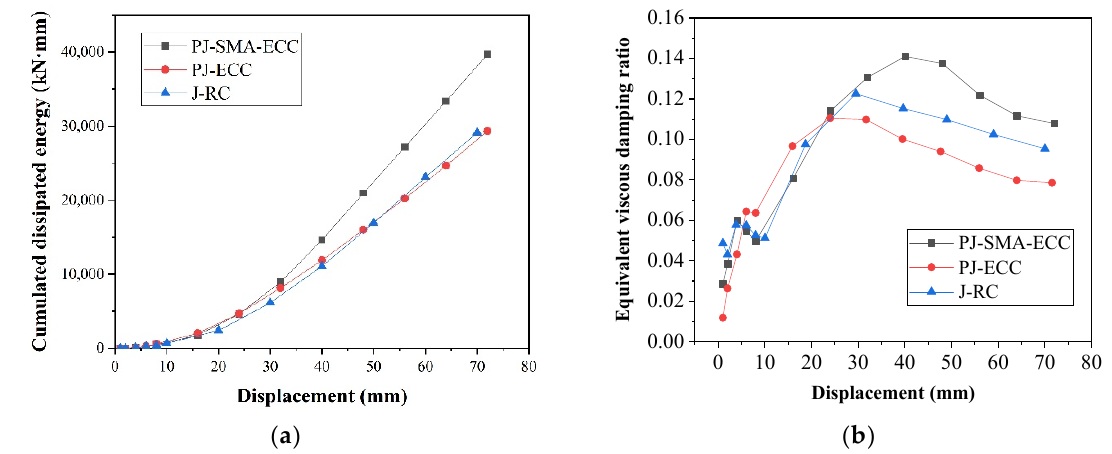
Figure 13. Dissipated energy for all the specimens. ( a ) Cumulative dissipated energy; ( b ) Equivalent viscous damping ratio.